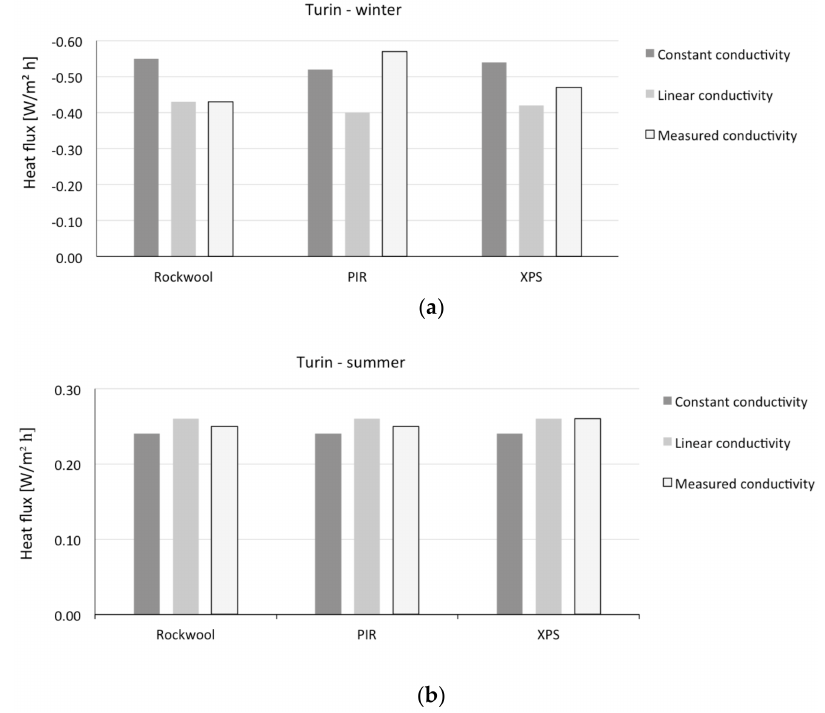
Figure 8. Heat flux average in flat roofs in Turin. ( a ) Turin—winter; ( b )